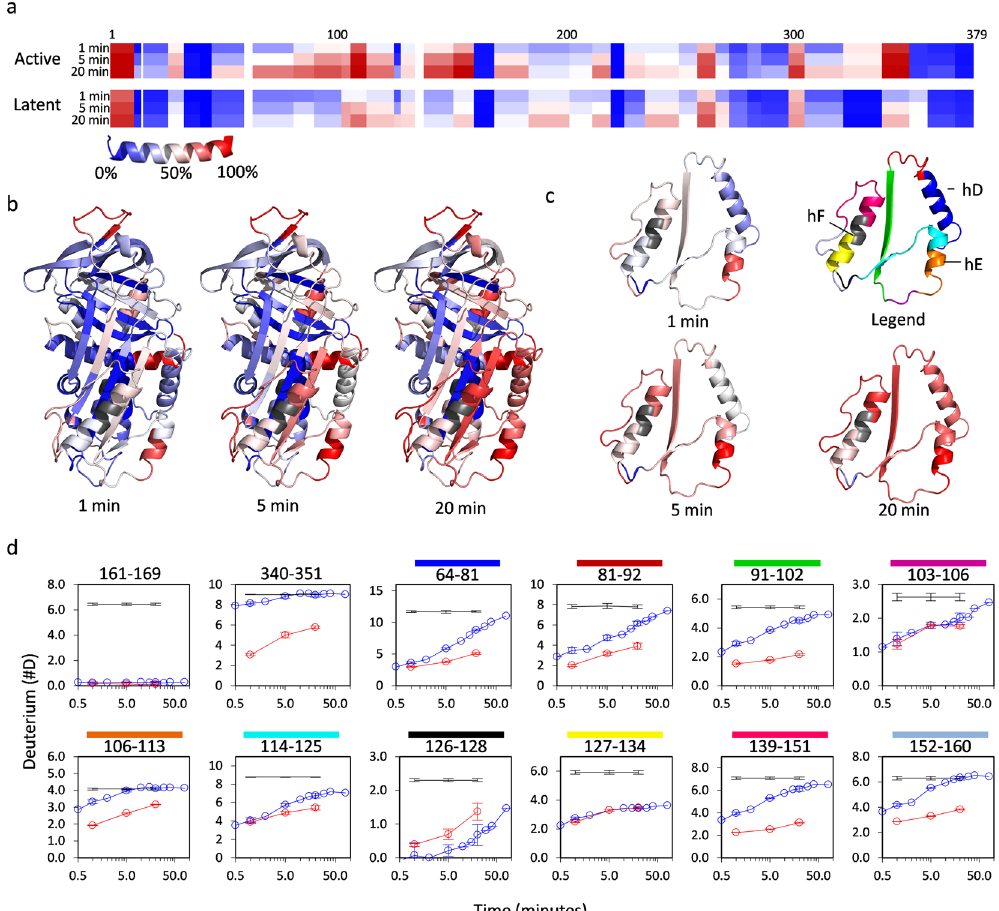
Figure 3. Hydrogen/deuterium-exchange mass spectrometry on active and latent PAI-1 at 5 °C. 40 pmol of active PAI-1 was diluted 100-fold into deuterated PBS pD 7.4 and incubated for 0.5, 1, 2, 5, 10, 15, 20, 30, 40 and 80 minutes at 5 °C prior to proteolytic digestion and analysis by LCMS. Latent PAI-1 was analyzed in a similar manner although only after 1, 5 and 20 minutes incubation. All 1, 5 and 20 minute time points were conducted in triplicate. ( a ) Heat map representing the deuterium content of individual peptides relative to a full deuteration control (see methods) after 1, 5 and 20 minutes incubation. ( b ) The HDXMS heat map of active PAI-1 from ( a ) shown on the active PAI-1 structure (PDB 3Q02) with the W175F substitution and RCL modelled in using Modloop 41, 42 . Grey areas represent sequences not covered by peptide HDX data. Similar representation of the latent PAI-1 HDXMS data is shown in Figure S5. (c) Heat map from ( a ) shown on residues 66-161 only. The upper right depiction is a color map to locate peptides for which deuterium uptake plots are shown in ( d ). ( d ) deuterium uptake plots of the indicated peptides. Active and latent PAI-1 are indicated by the blue and red line, respectively, and the full deuteration level by the black line. Error bars represent the standard deviation from triplicate